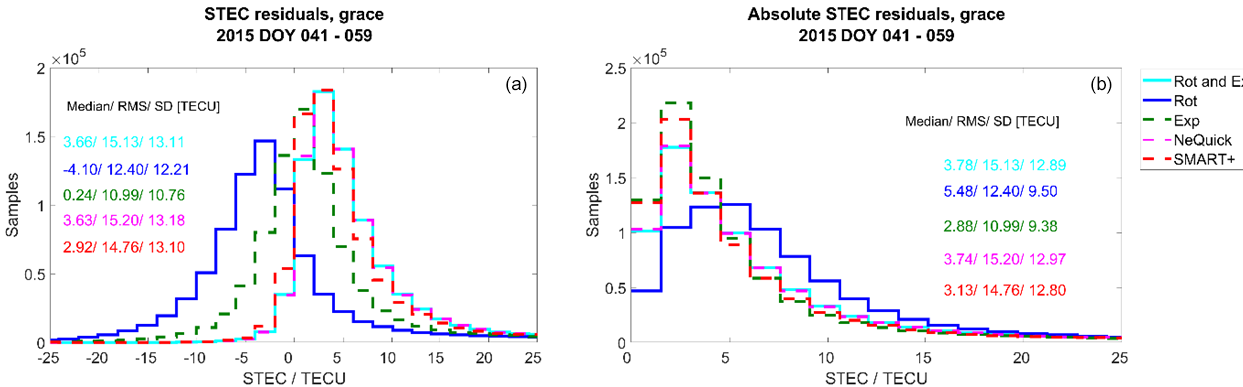
Figure 14. Histograms of the STEC residuals (a) and absolute residuals (b) during the quiet period for